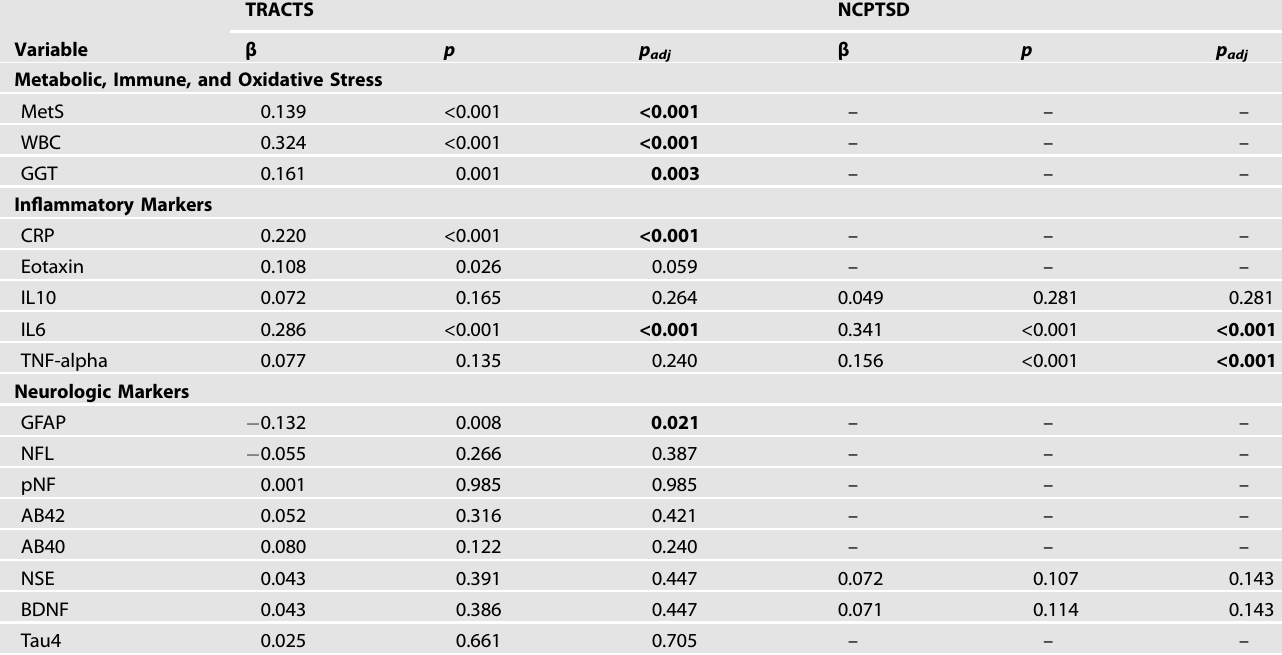
Bolded values re fl ect p or p adj <0.05.